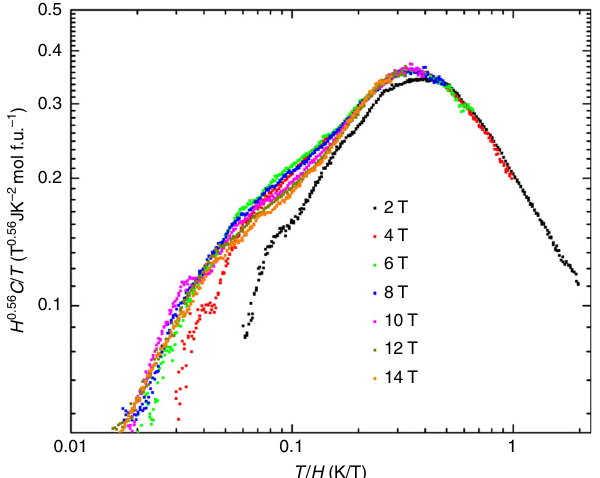
Fig. 3 Data collapse in LiZn 2 Mo 3 O 8 . Data from Fig. 2 rescaled by the scaling ansatz H 0.56 C / T . The data collapses to a function of the single variable T / H , asymptoting as ( T / H ) for T (cid:1) H and ( T / H ) − 0.56 for T (cid:5) H , consistent with the q = 1 scaling theory Eq. (2) and Fig. 1